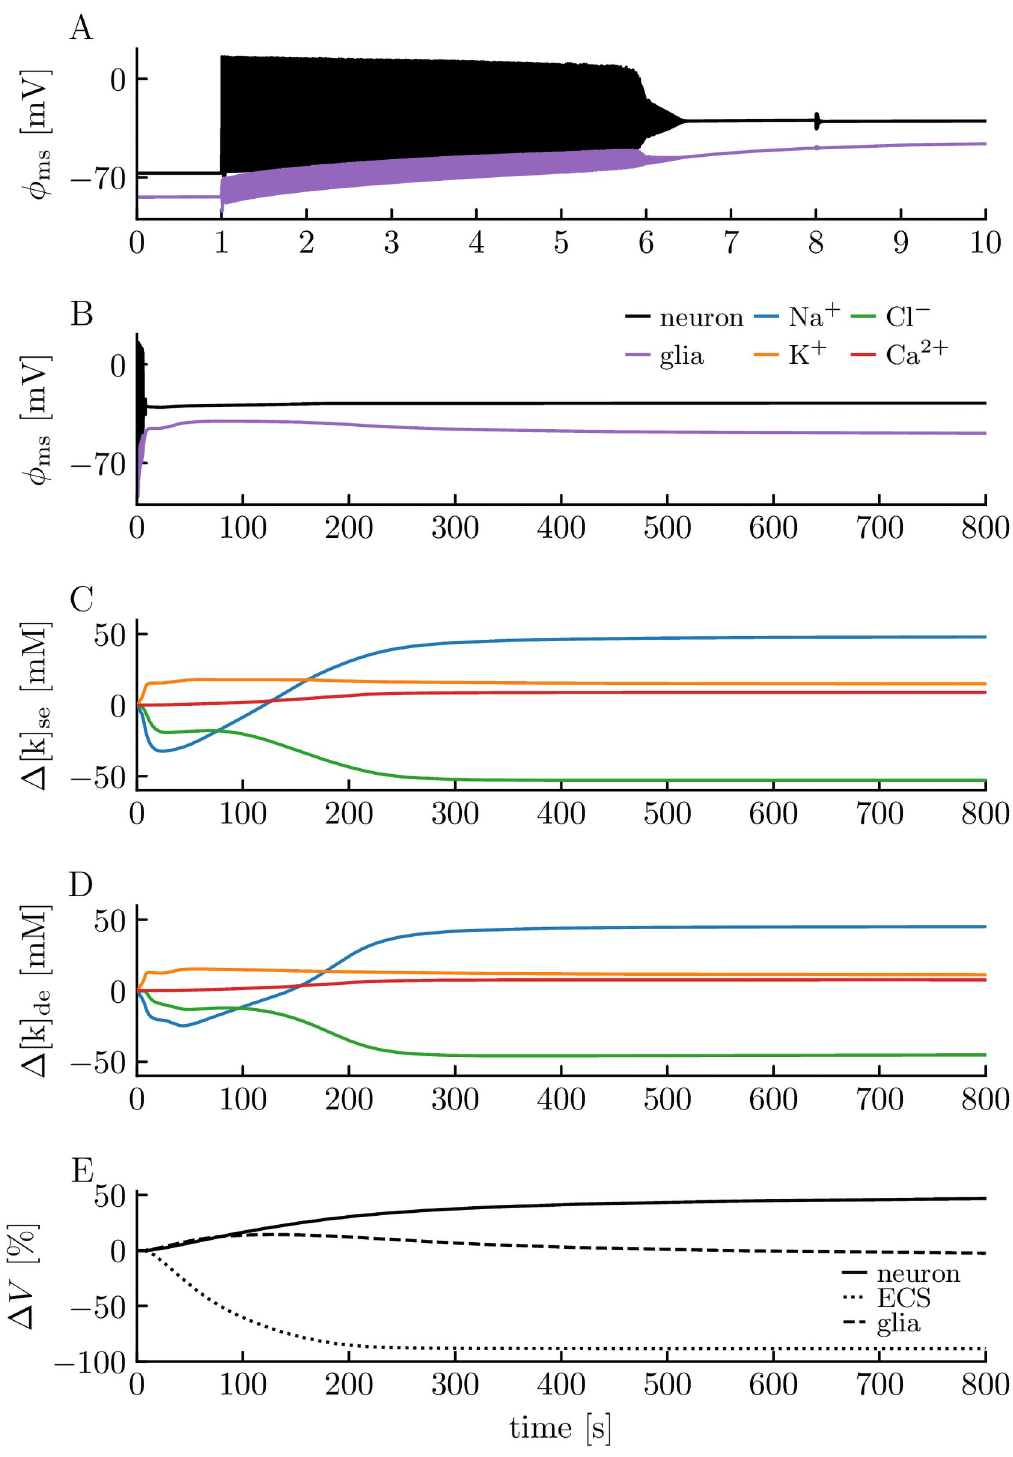
Fig 4. edNEG modeling of pathological activity. Model response to a 150 pA step-current injection to the somatic compartment of the neuron between t = 1 s and t = 8 s. (A) The neuron responded with an initial firing rate of 57 Hz, but both the firing rate and spike shapes varied throughout the simulation due to variations in the ion concentrations. Both the neuron (black line) and glia cell (purple line) experienced a gradual depolarization throughout the simulation, and the neuron eventually went into depolarization block, where it stayed throughout the rest of the simulation (B) . The gradually changing